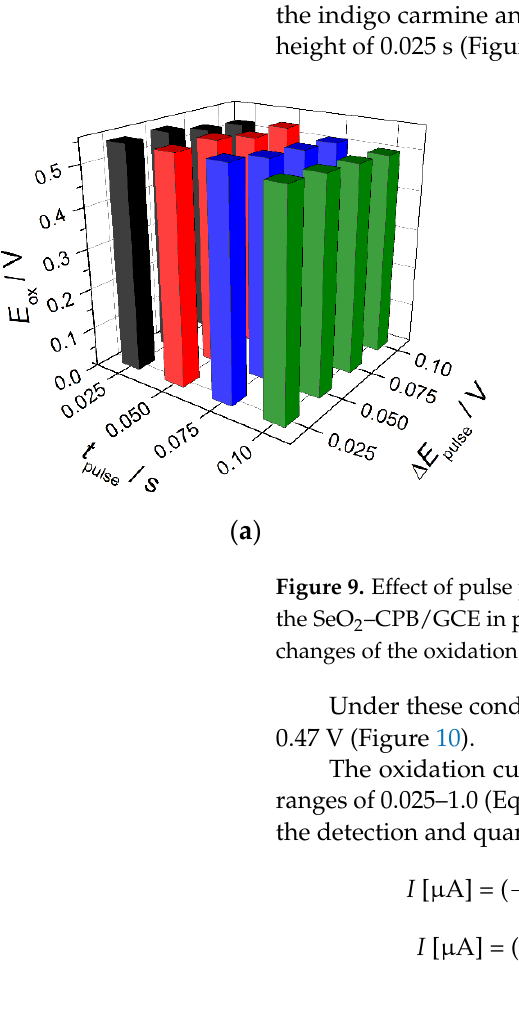
( b ) Figure 10. Baseline-corrected differential pulse voltammograms of indigo carmine at the SeO 2 – CPB/GCE in phosphate buffer pH 5.0: ( a ) 0.025–1.0 µM; ( b ) 1.0–10 µM. Pulse width is 0.10 V, pulse height is 0.025 s, and potential scan rate is 10 mV s ‒ 1 . The oxidation currents are linearly dependent on the colorant concentration in the ranges of 0.025–1.0 (Equation (8), Figure S2a) and 1.0–10 µM (Equation (9), Figure S2b) with the detection and quantification limits of 4.3 and 14.3 nM, respectively. I [µA] = ( − 0.0089 ± 0.008) + (55.9 ± 0.2) × 10 4 c [M] R 2 = 0.99994,